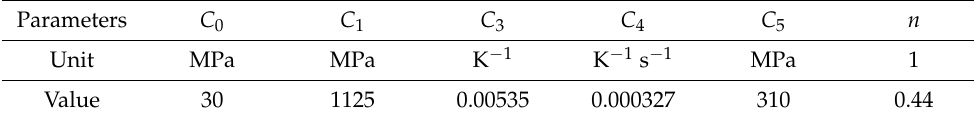
Table 8. Parameters of the ZA model for a BCC material (tantalum) ( Parameters